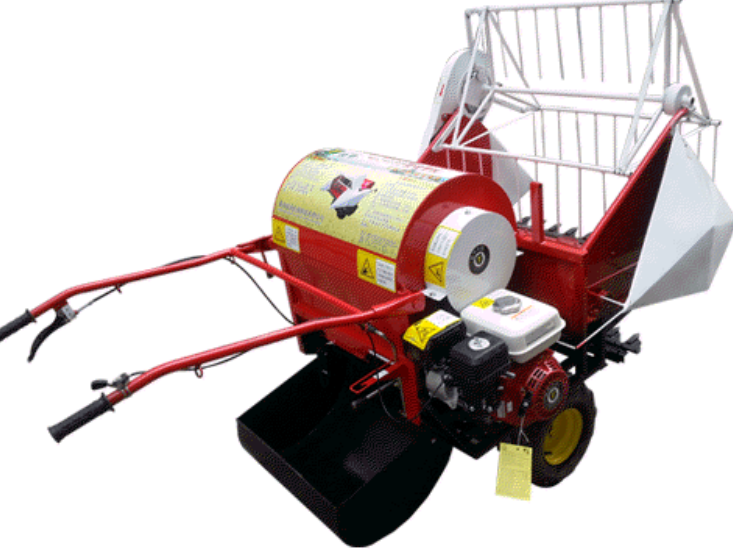
Figure 6. Tiejia 4LZ-0.3 harvester.